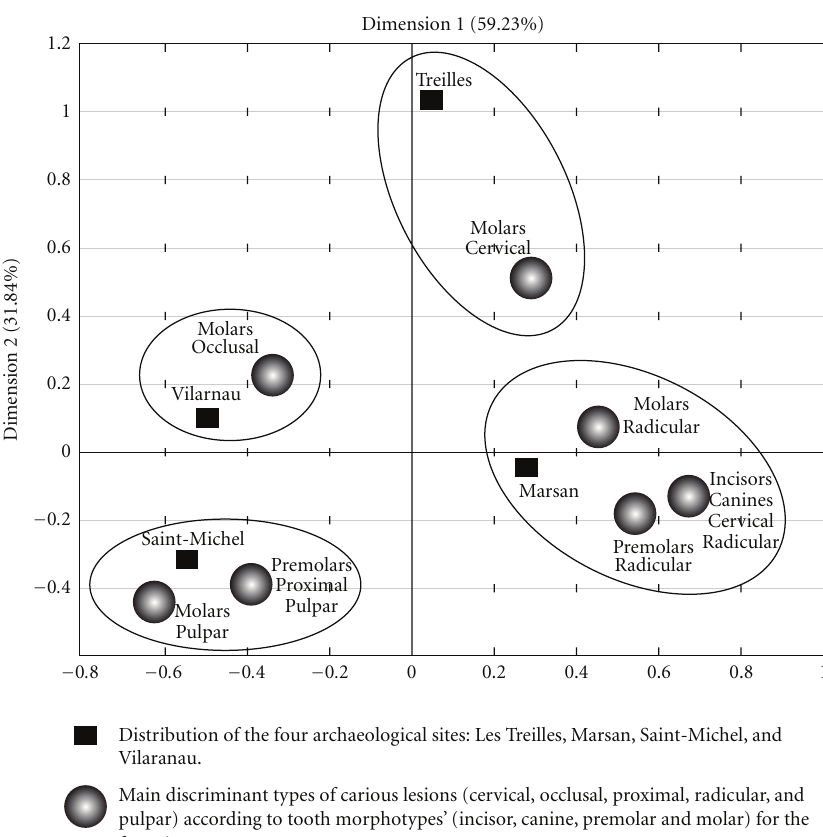
Figure 2: Distribution of the four populations according to caries by principal analysis. In relation to dimension1, Marsan was opposed to Vilarnau and Saint-Michel. In relation to dimension 2, the 3 sites Marsan, Vilarnau, and Saint-Michel were opposed to Les